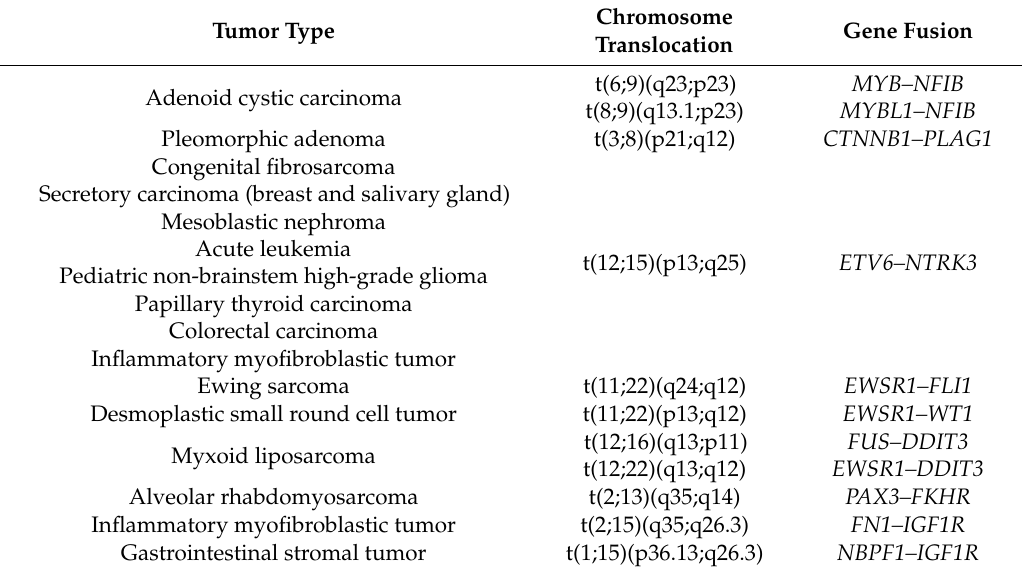
Table 1. Examples of chromosome translocations and gene fusions interacting with components of the insulin-like growth factor (IGF) signaling